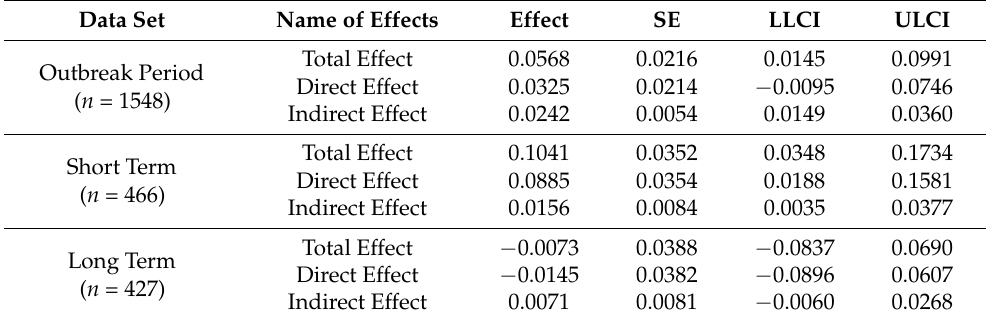
Table 3. Mediating effects of FD between SP and